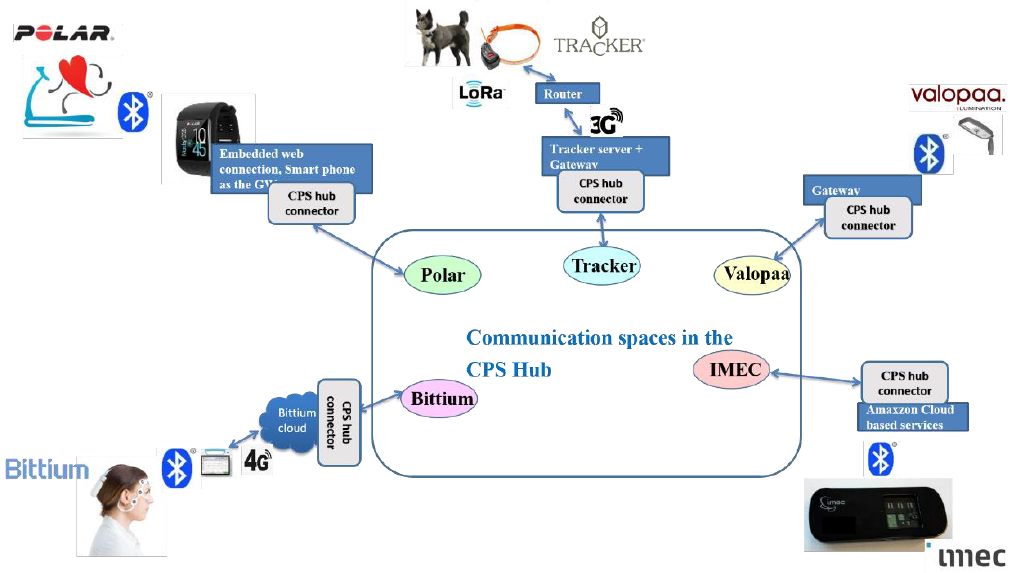
Figure 11. Example attachments of physical CPS resources to the CPS hub.